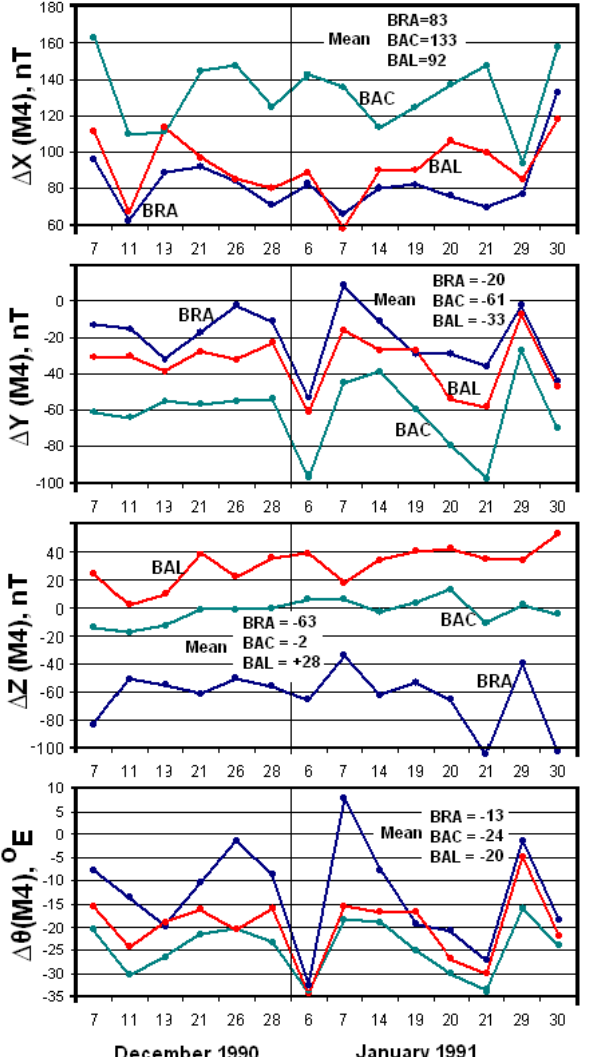
Fig. 10. Day-to-Day variations of 1X , 1Y , 1Z and θ at the BAC station near the centre of EEJ and at the BRA and BAL stations near the edges of EEJ.